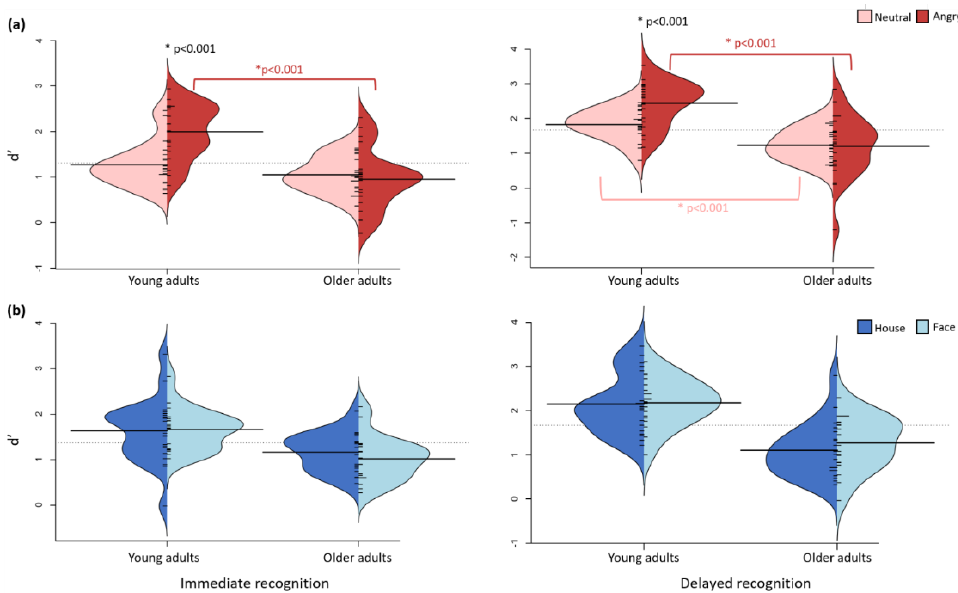
Figure 4. Split violin plots presenting the d’ for emotion and category. ( a ) Split violin plots displaying d’ as a function of emotion, group, and interval. In the young adults group, d’ was significantly higher for angry faces compared to neutral faces for both IR and DR (all ps < 0.001). ( b ) Split violin plots displaying d’ as a function of category, group, and interval. The results reveal a main effect of group for both IR and DR (all ps < 0.002). * p < 0.05. Table 2. Correlations between immediate recognition and delayed